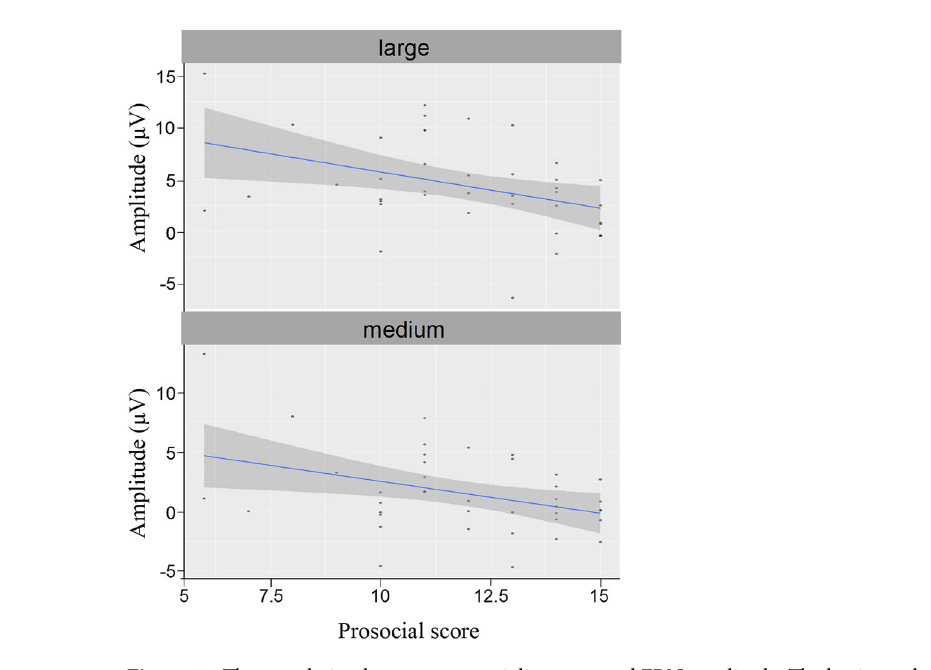
Figure 5. The correlation between prosociality score and FRN amplitude. The horizontal coordinate is the prosocial score, and the total coordinate is the amplitude of